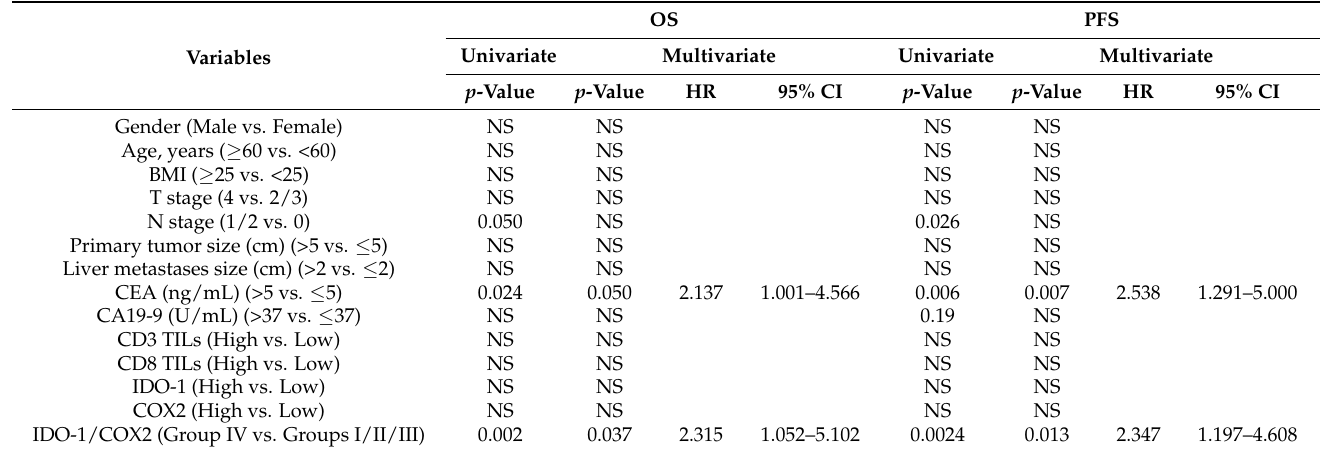
Table 2. Univariate and multivariate analysis of the correlation of clinicopathological parameters with prognosis in patients with liver metastases of colorectal